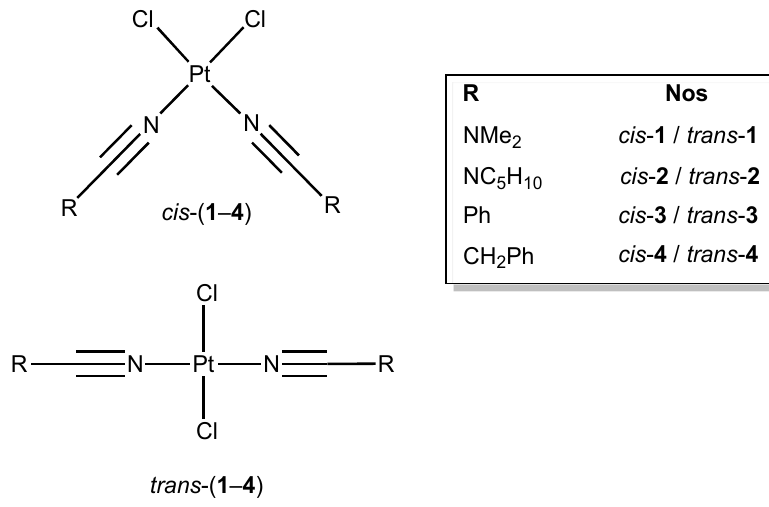
Figure 1. Platinum complexes employed as hydrosilylation cross-linking catalysts. Table 1. Parameters of the catalytic cross-linking of PDMS and EHDMS.